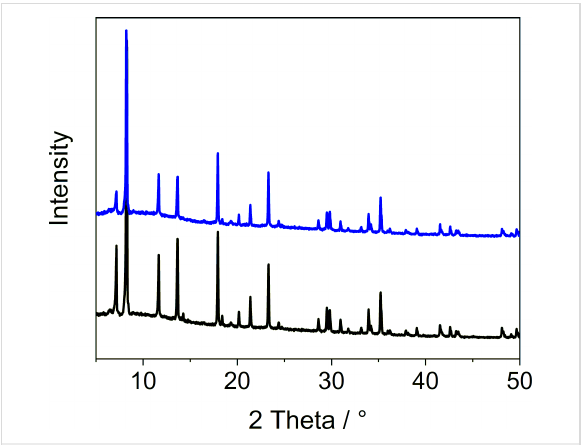
Figure 3: Powder X-ray diffraction analysis of MFU-4 before (black) and after (Sample 3a, blue) the loading of SF 6 .